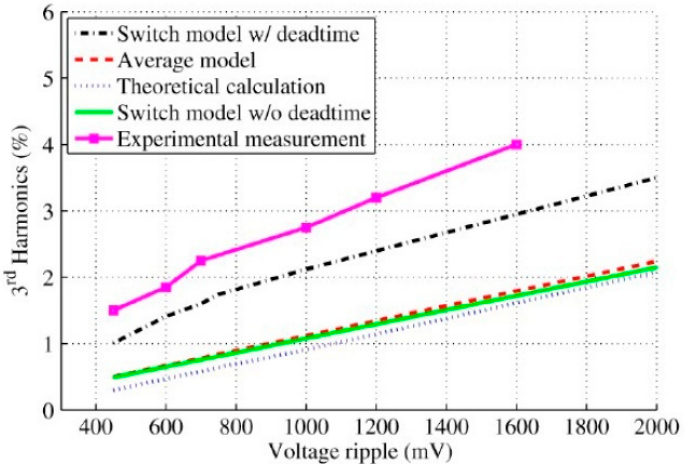
Figure 1. Impact of BESS/PVDG DC-link voltage ripples on harmonics [32].